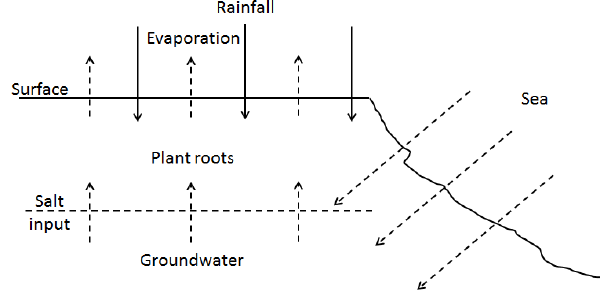
Figure 2. Soil salinization process in the study